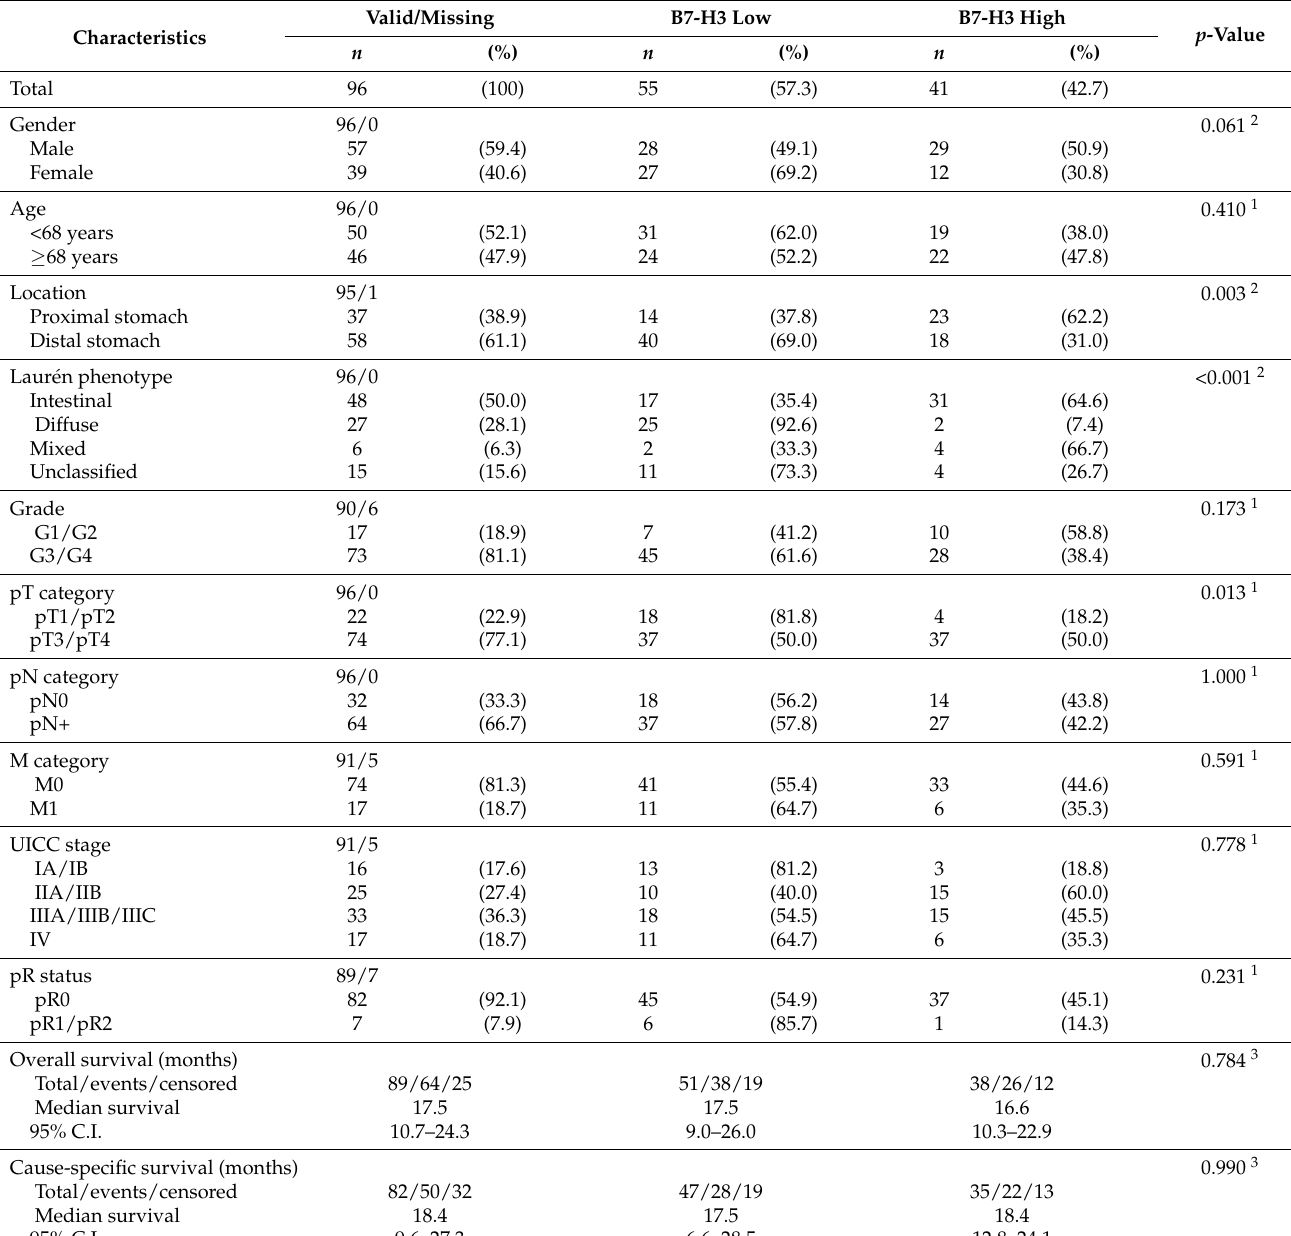
Table 1. Clinicopathological patient characteristics and correlation with B7-H3